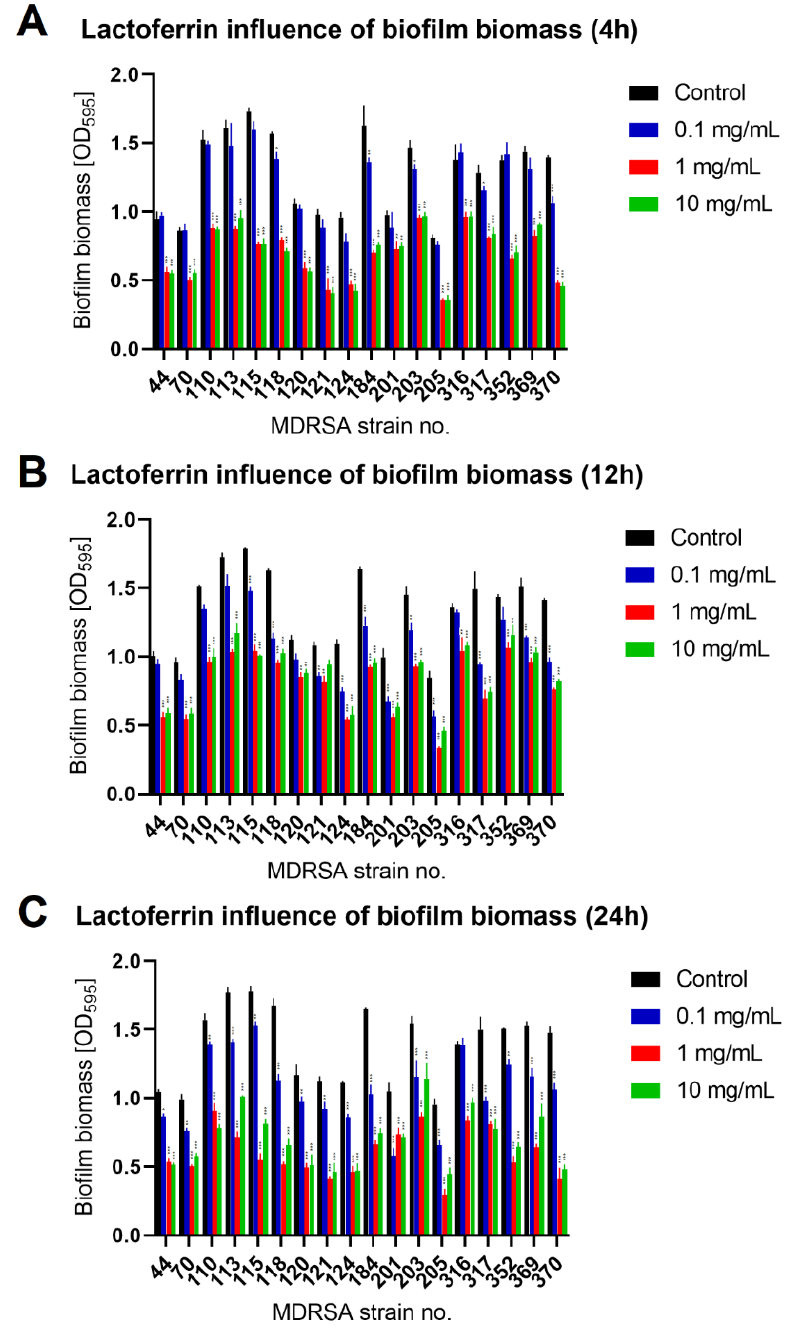
Figure 2. Influence of lactoferrin (0.1 mg/mL, 1.0 mg/mL and 10 mg/mL) on MDRSA biofilm biomass after 4 h ( A ), 12 h ( B ) and 24 h ( C ) of incubation. Mean of triplicates, with error bars representing SD. Statistical analysis was performed using t -test, p < 0.05 (*), p < 0.01 (**), p < 0.001 (***).